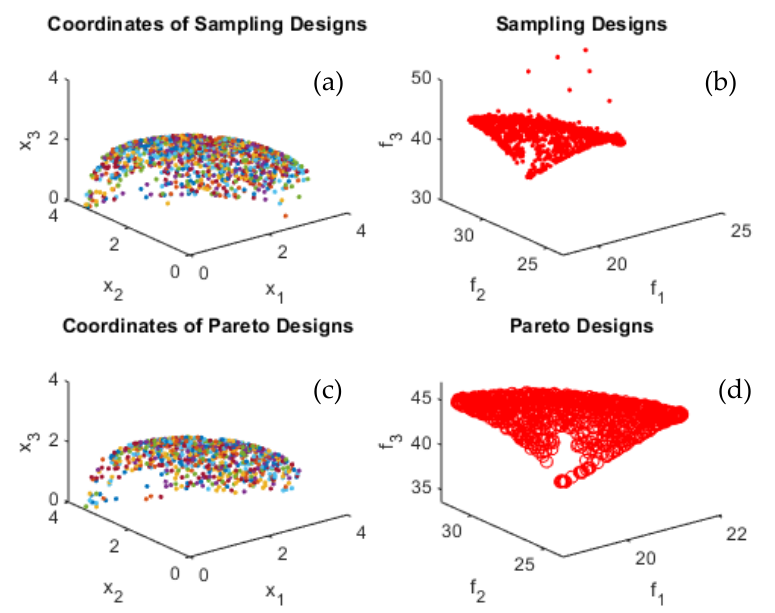
Figure 8. Computational simulations Pareto frontier determination of test function T3 ( a ) coordinates od sampling points; ( b ) sampling points in feasible design space; ( c ) coordinates of Pareto points; ( d ) the seeking Pareto frontier.